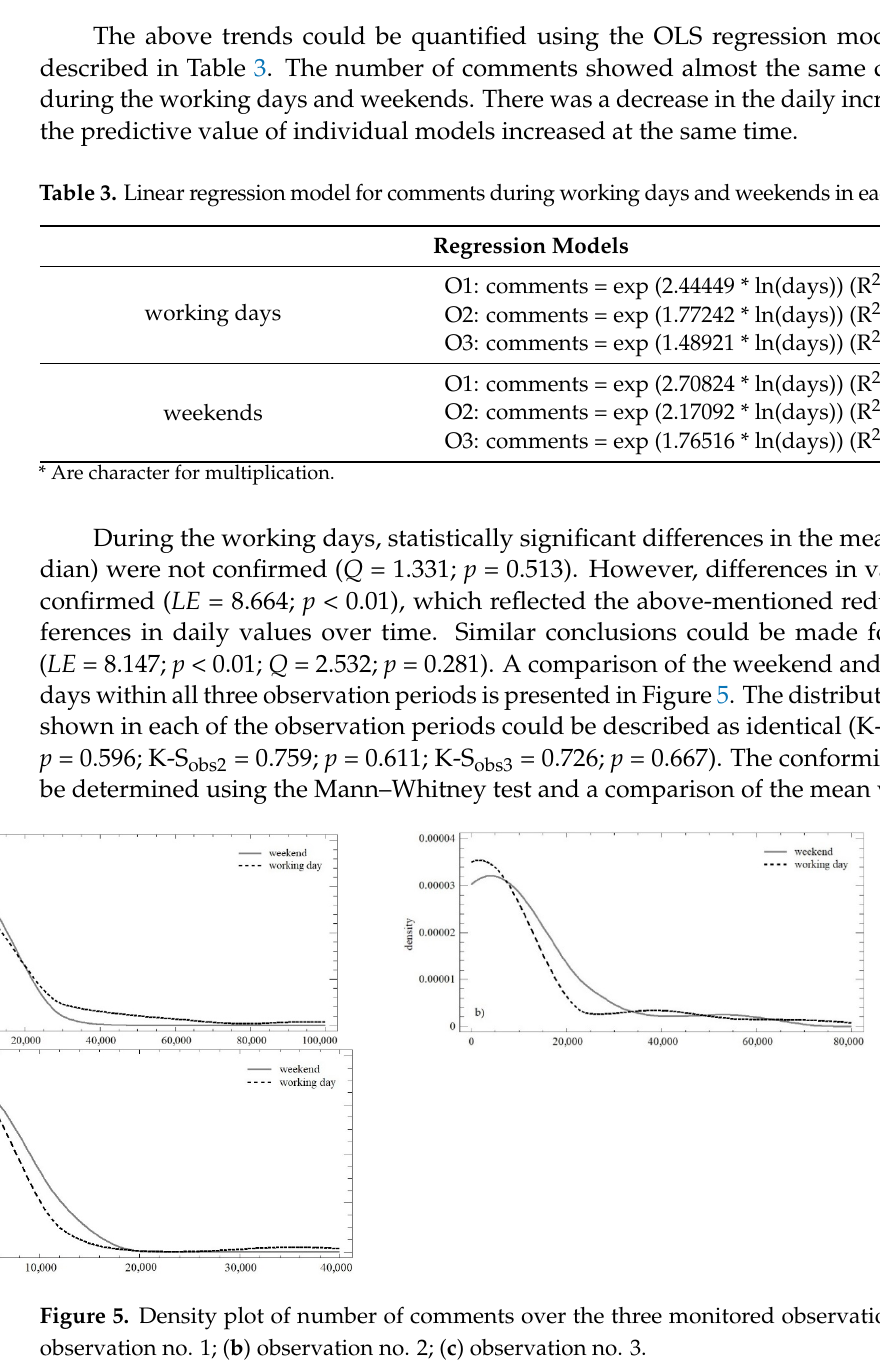
Figure 4. Scatterplot of the numbers of comments across the observation periods: ( a ) working days; ( b ) weekend. ( b ) weekend.